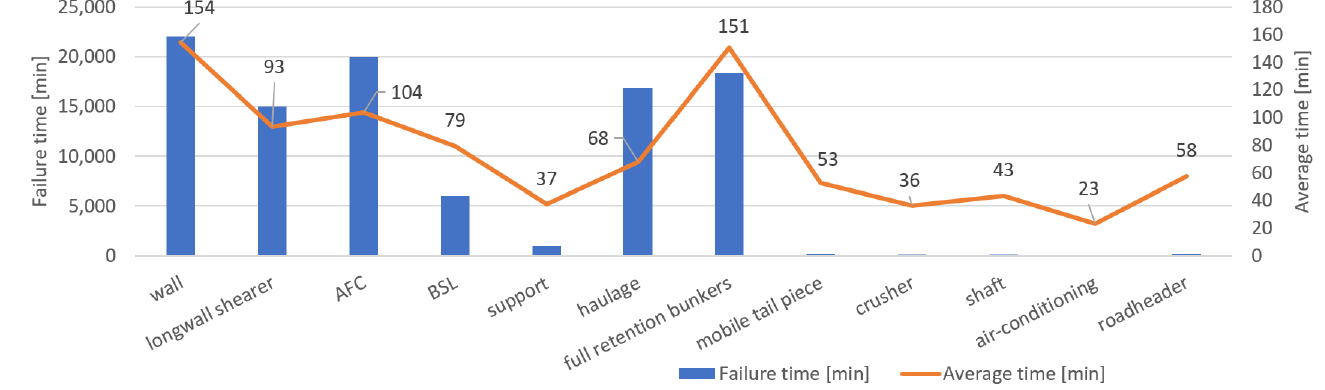
Figure 5. Duration of failures and average duration of failures of shearer longwalls in total.